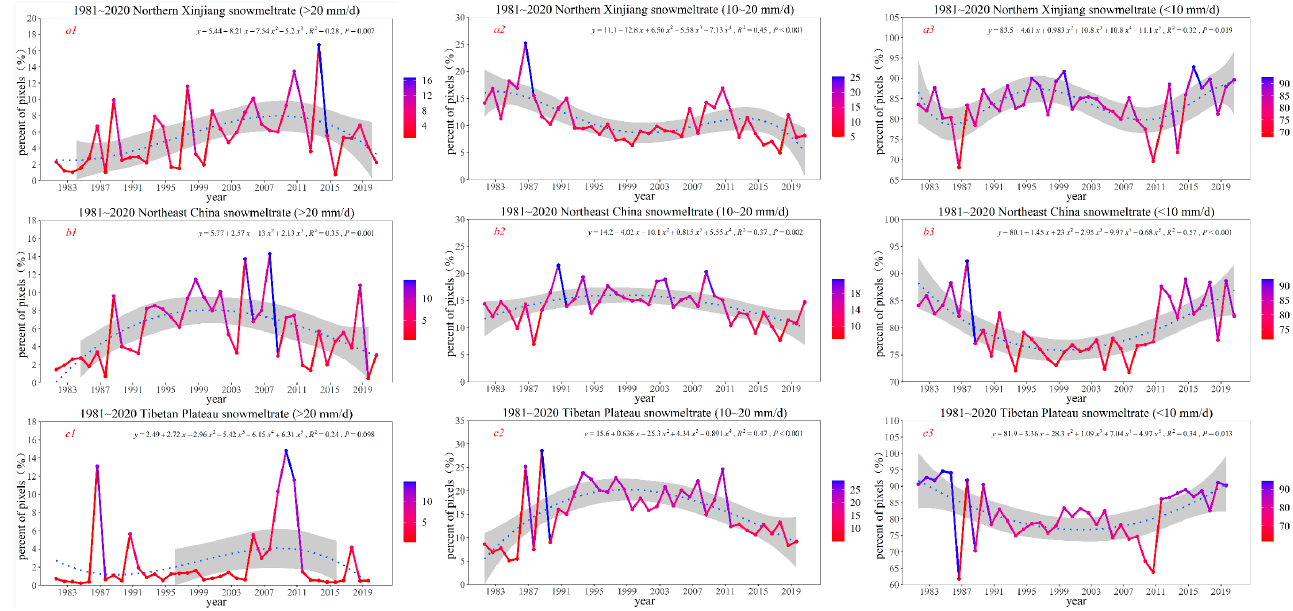
Figure 5. Time-series analysis of changes in the snowmelt rates in spring over the past 40 years across China’s three stable snow cover regions, obtained from passive microwave remotely sensing datasets. Top row: northern Xinjiang. Middle row: northeast China. Bottom row: Tibetan Plateau. The gray shading is the 90% confidence interval for the fitted nonlinear regression (dotted blue line).